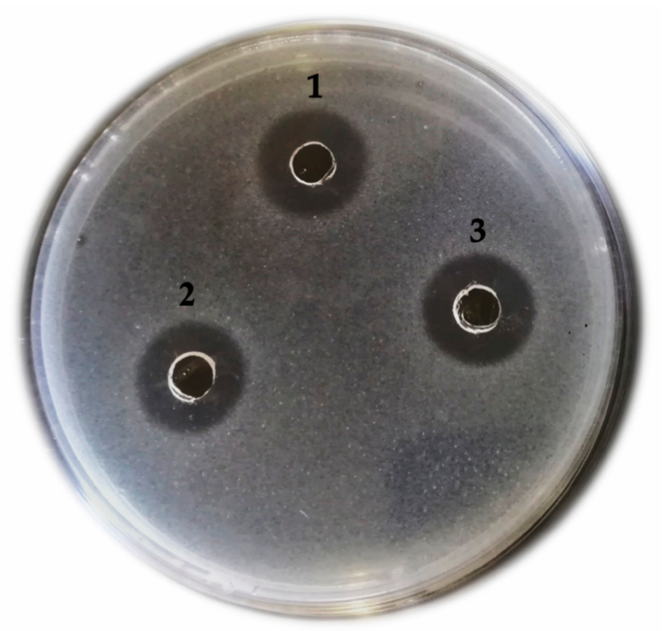
Figure 1. Growth inhibition activity of crude biopreservatives from Candida pyralidae Y1117 ( 1 ), Pichia kluyveri Y1125 ( 2 ), and P. kluyveri Y1164 ( 3 ) when Dekkera bruxellensis was used as the sensitive organism on a grape pomace extract